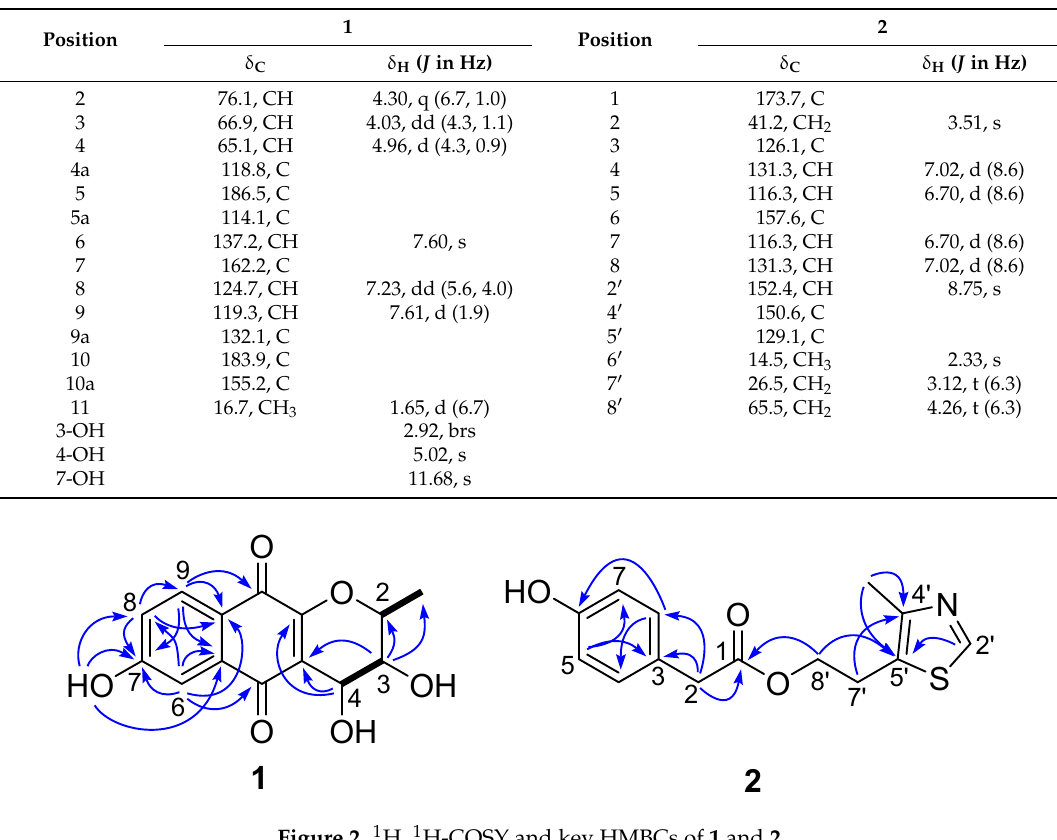
Figure 2. 1 H, 1 H-COSY and key HMBCs of 1 and 2 . Table 1. 1 H- (500 MHz) and 13 C- (125 MHz) NMR data of 1 in CDCl 3 and 2 in CD 3 OD.